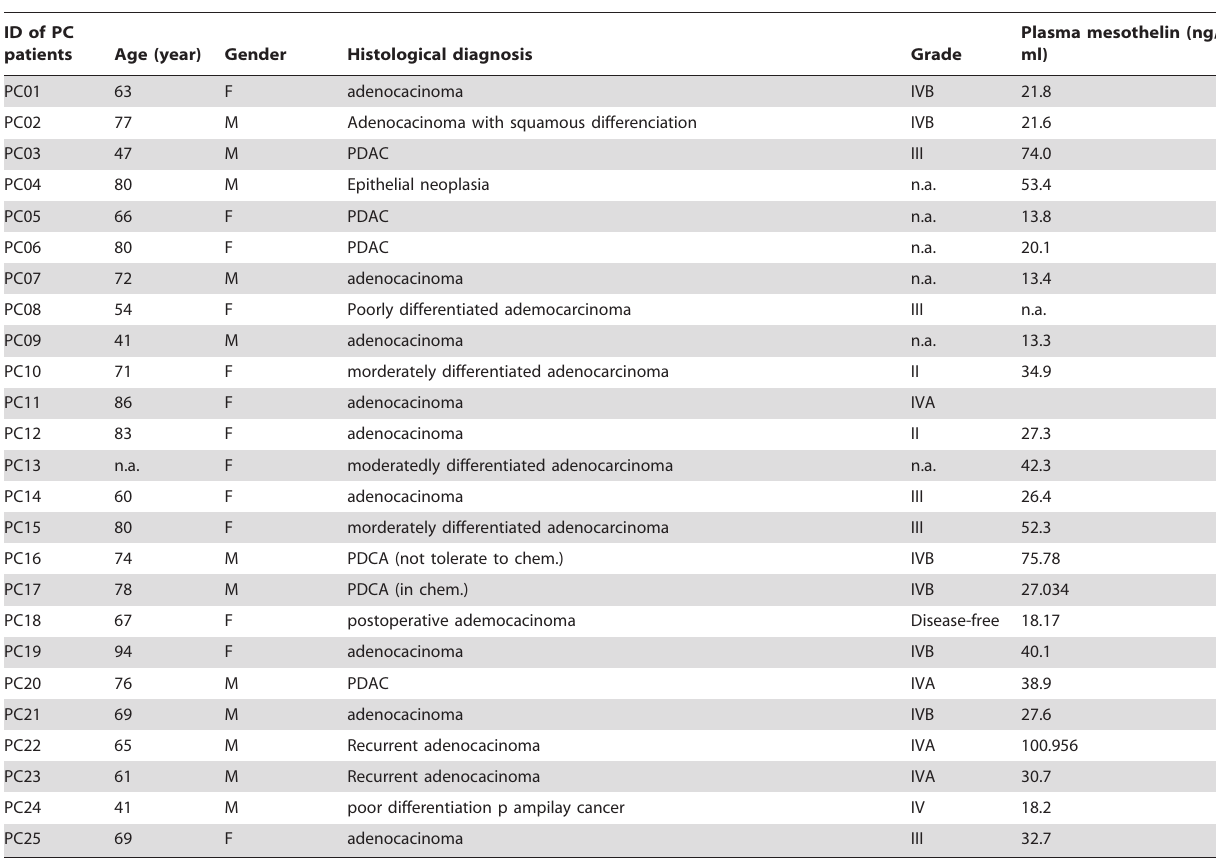
Table 1. Pancreatic cancer patients’ information.